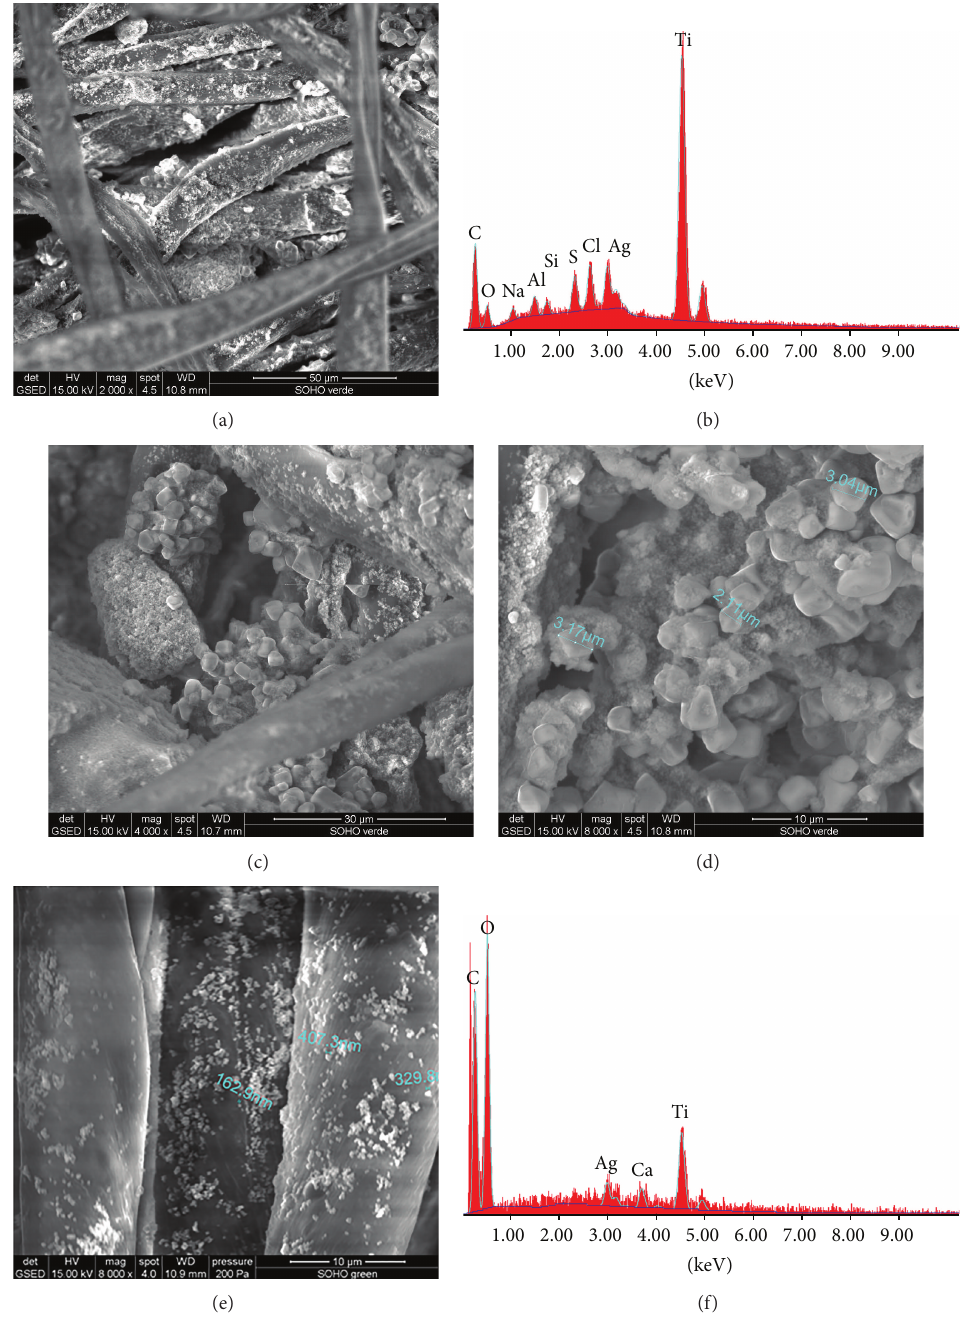
Figure 5: SEM and EDAX images for sample Igs (antimicrobial finished plasma functionalized type I green cotton 100%): (a) SEM image for sample Igs at resolution × 2000, (b) EDAX image for sample Igs, (c) SEM image for sample Ig at resolution × 4000, (d) SEM image for